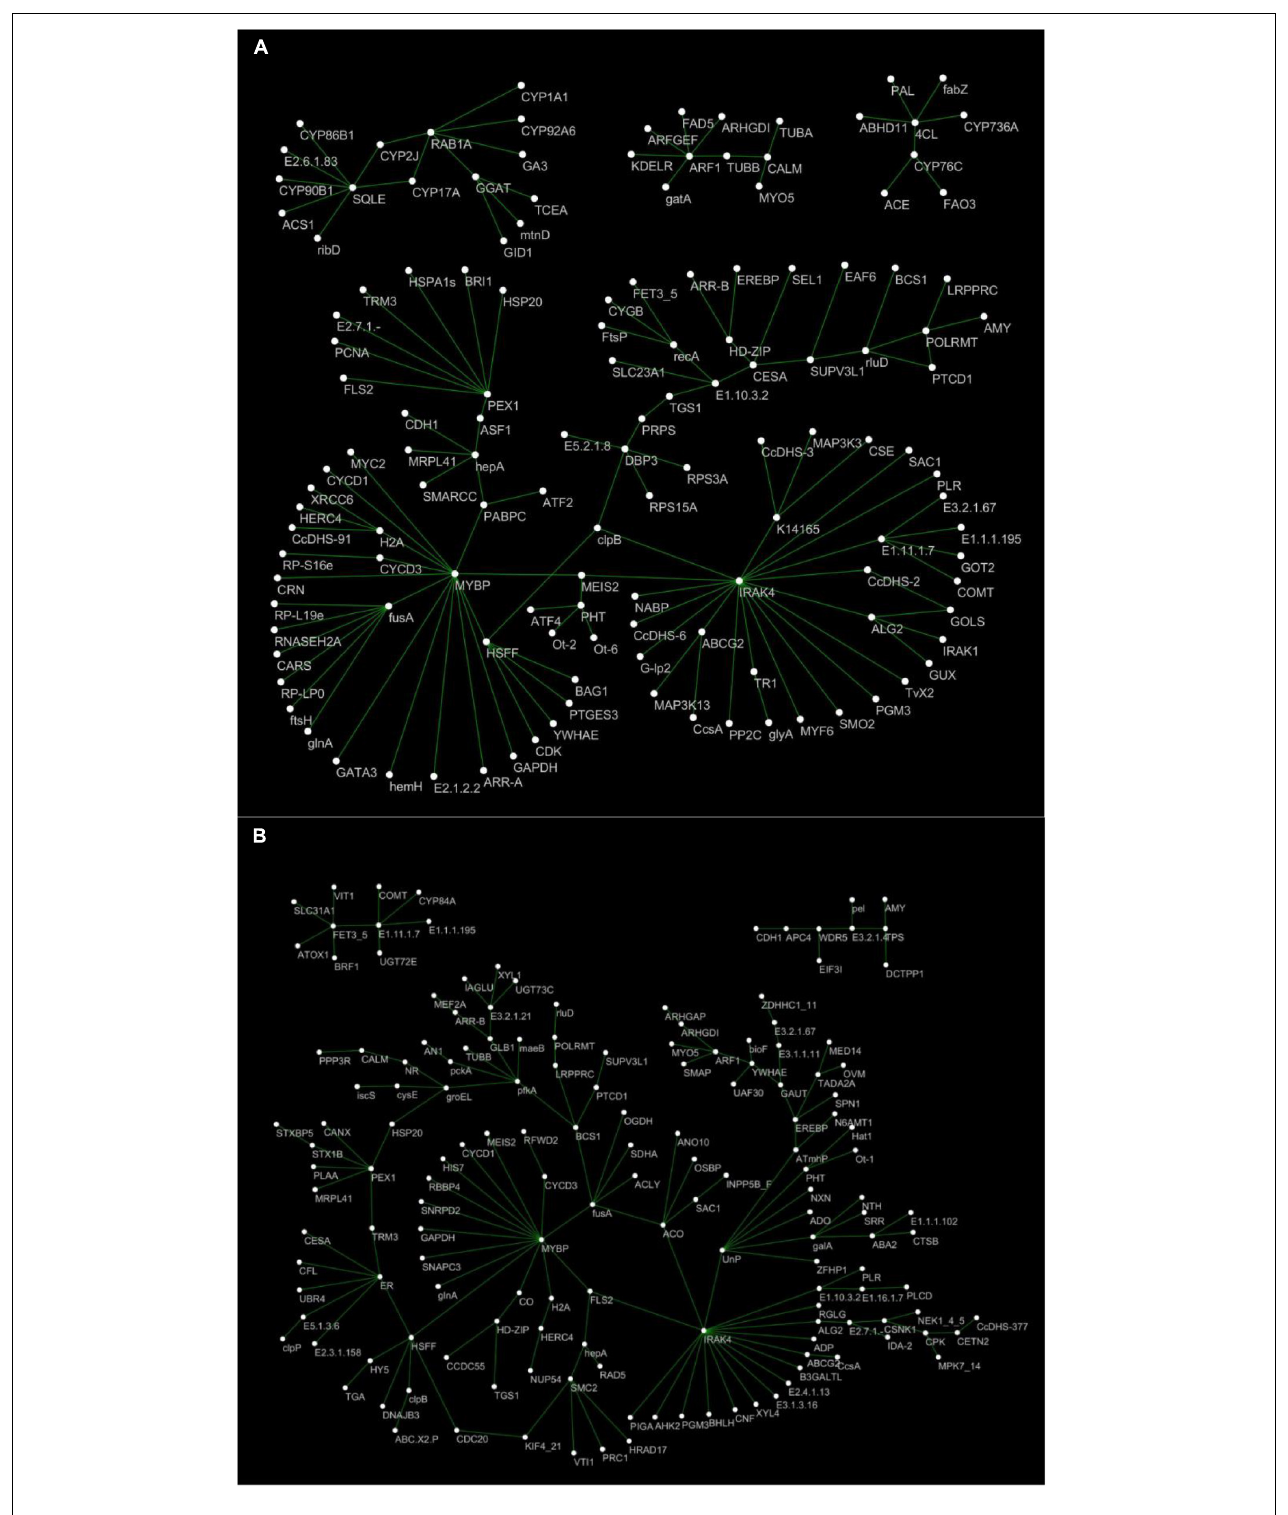
FIGURE 8 | Protein interaction network in the seed coat of hulled and hull-less C. pepo. Each node represents a DEG. (A) PPI network of 1,831 DEGs in the seed coat of hull-less C. pepo L. (B) PPI network of 2,099 DEGs in the seed coat of hulled C. pepo .